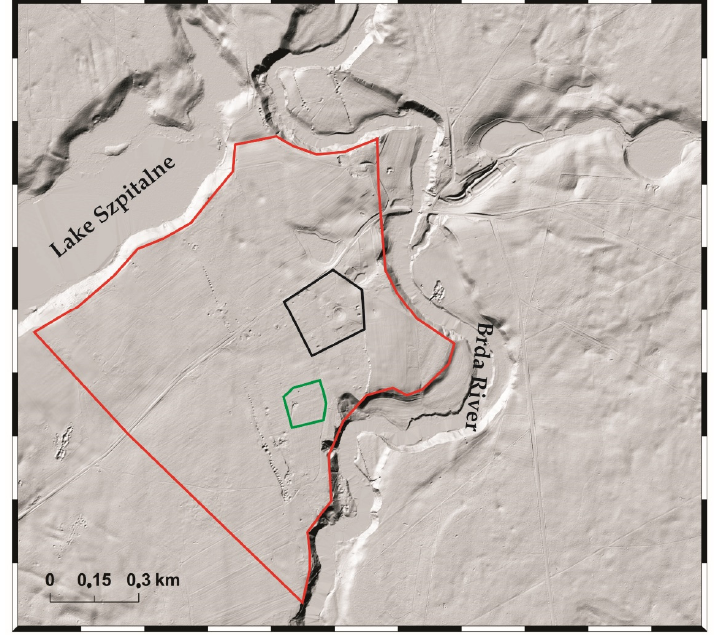
Figure 2. Post-mining areas in Pi ł a M ł yn. 1—area with brown lignite deposits (red marking), 2— residential area (black color), 3—area of tourist attraction “Mining Village” (green color), source: [28].